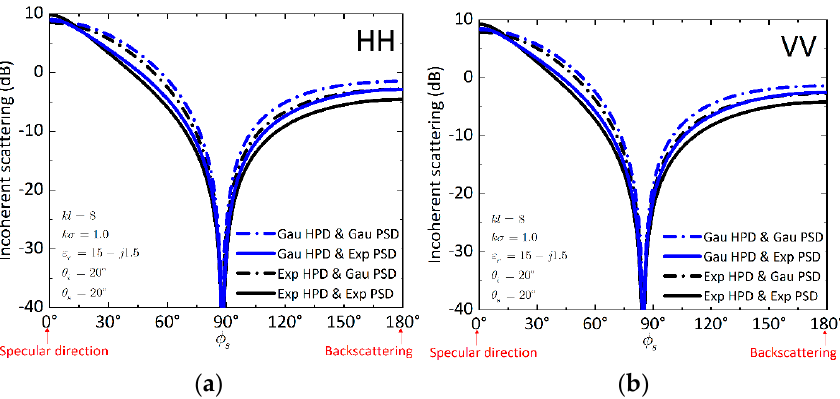
Figure 6. Comparison of bistatic incoherent scattering in an incident plane for four types of surfaces: Gau HPD and Gau PSD, Gau HPD and Exp PSD, Exp HPD and Gau PSD, Exp HPD and Exp PSD. The related parameters are ( b ) VV polarization.